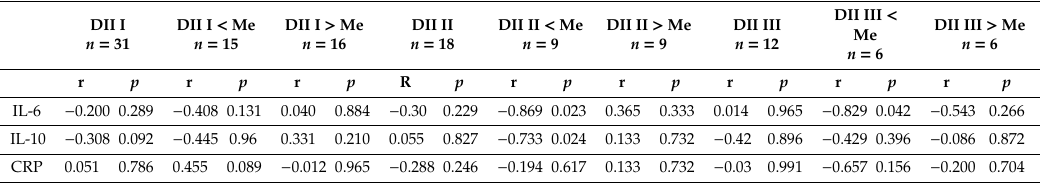
Table 5. Correlation analysis of DII score with IL-6, IL-10, and CRP levels in the particular trimesters among pregnant women with normal pregnancy.